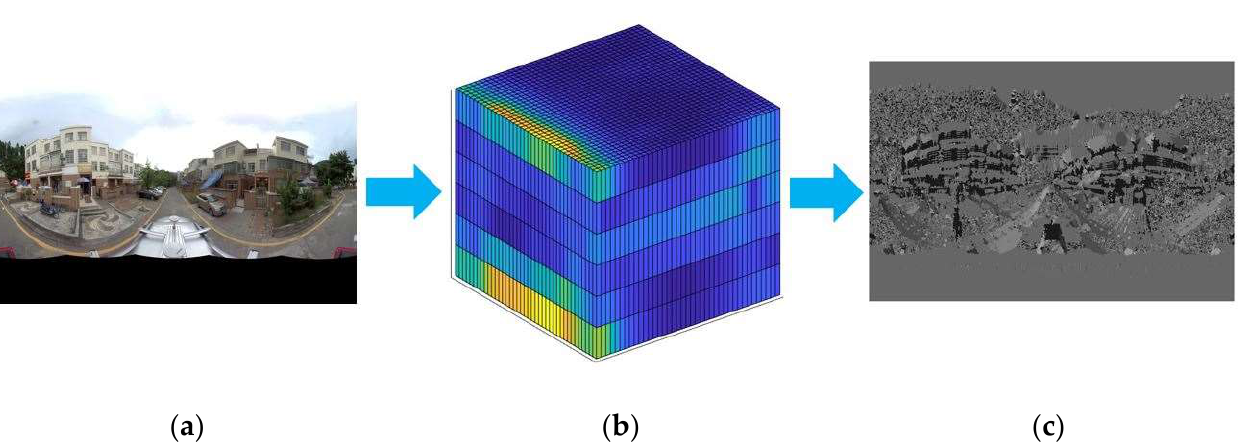
Figure 4. Index map generation: ( a ) original image; ( b ) log-Gabor convolution image sequence; and ( c ) index map.